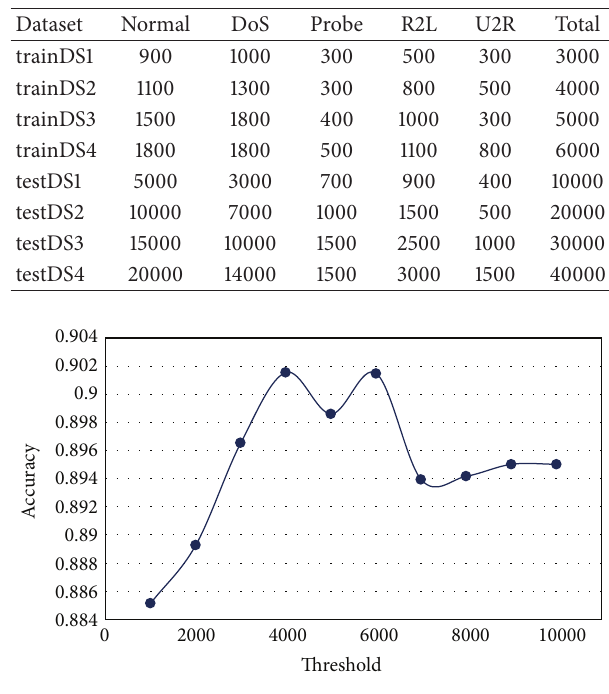
Figure 2: Computing the best threshold value for modified 𝐾 - means.